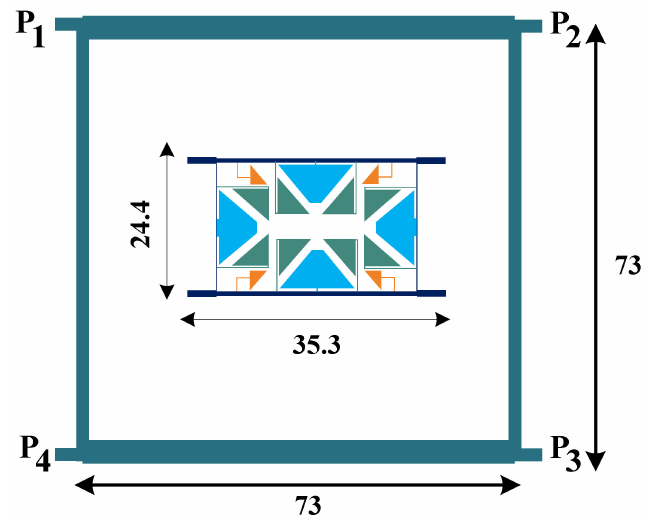
Figure 16. Layouts comparison between the final prototype of the designed coupler (24.4 mm × 35.3 mm) and the conventional couplers (73 mm × 73 mm) at 750